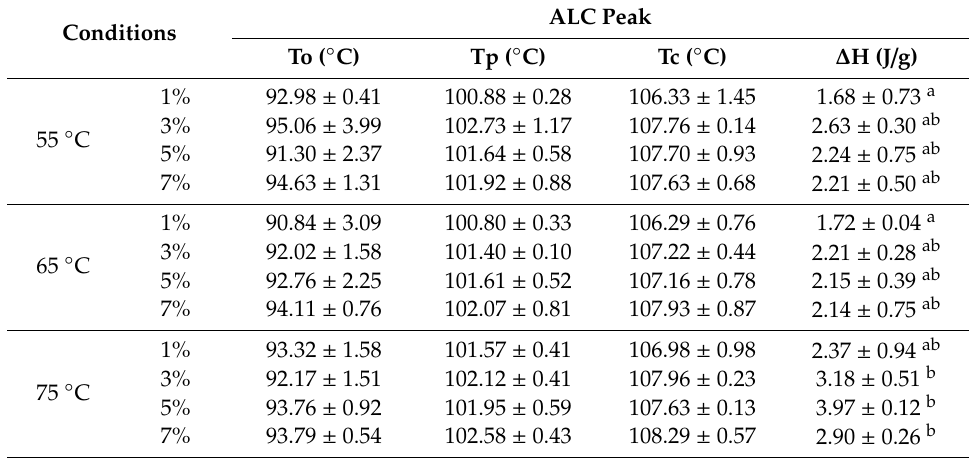
Table 3. Thermal properties of amylose-lipid complexes (ALCs) prepared under di ff erent conditions. Conditions